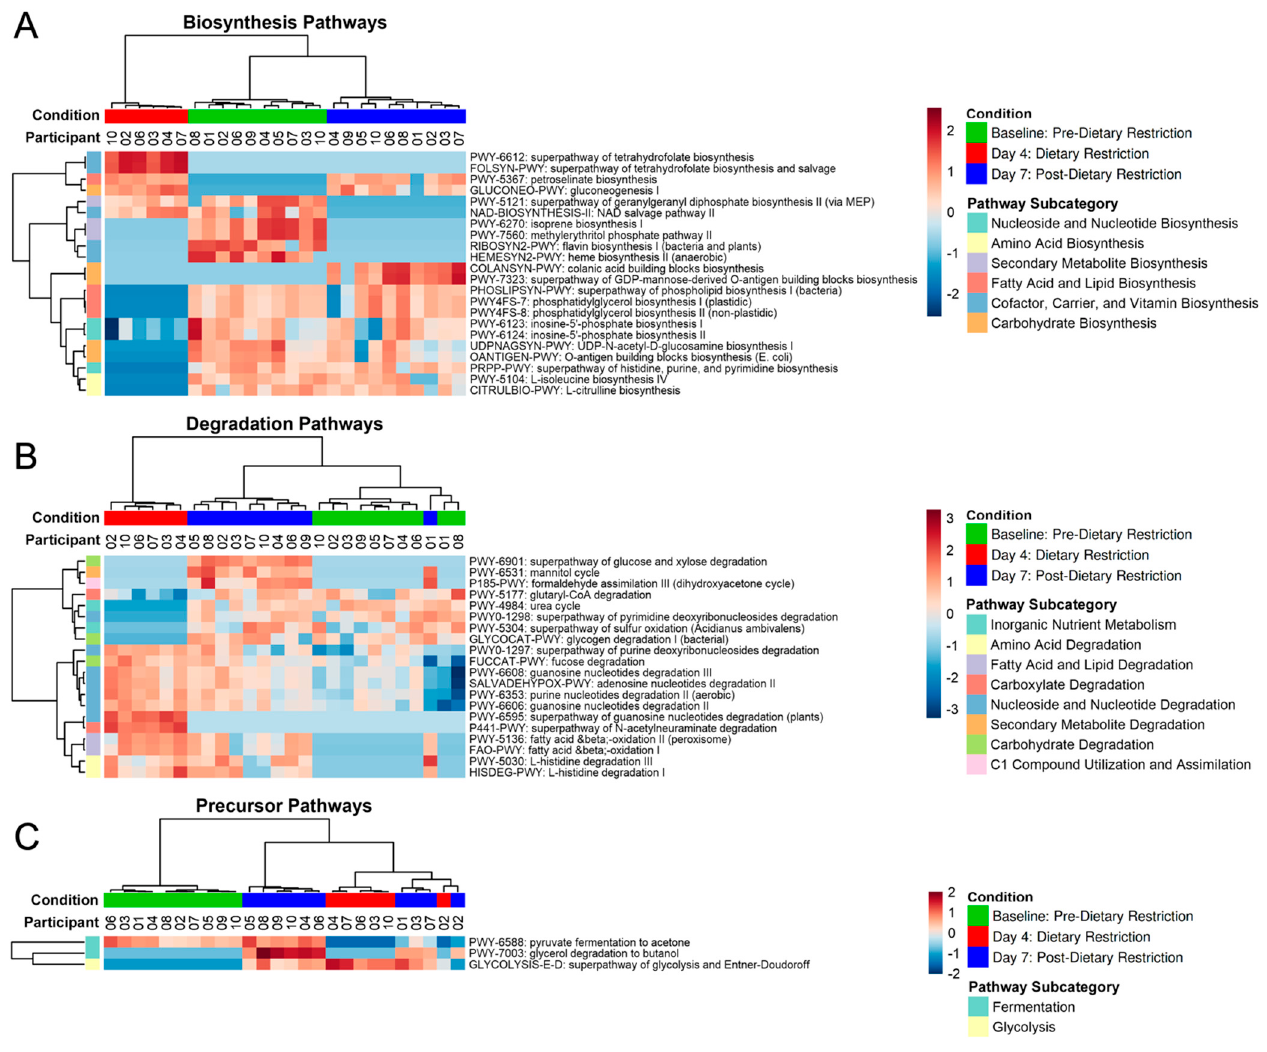
Figure 8. Heatmap of significantly different pathways (FDR p < 0.05). Based on MetaCyc ontology classification, pathways were categorized as biosynthesis ( A ), degradation ( B ), or precursor metabolic pathways ( C ).